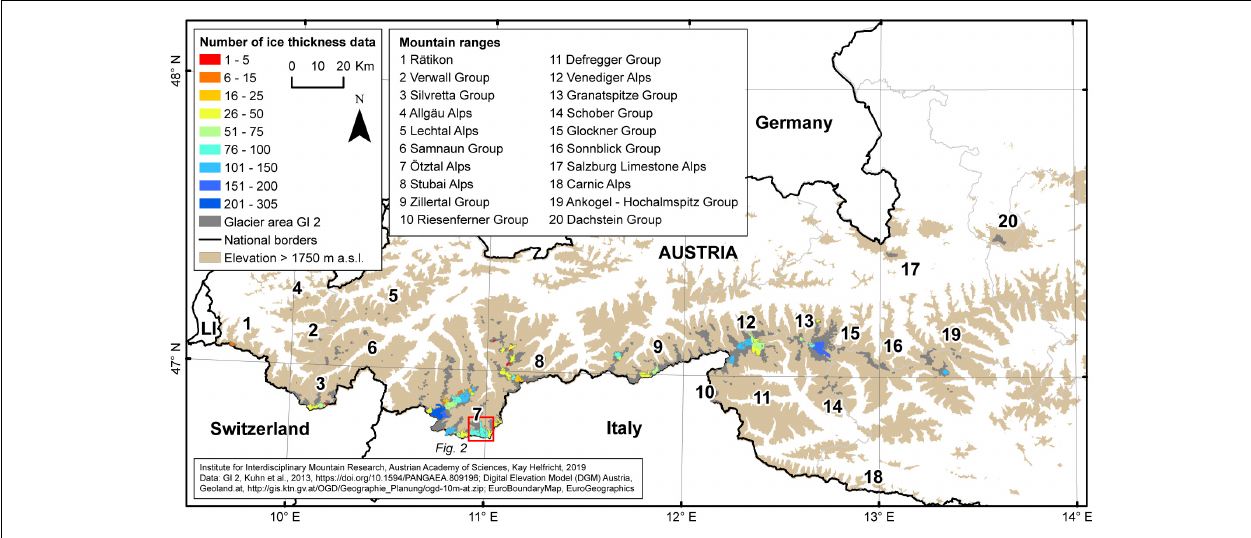
FIGURE 1 | Location of the glaciers according to the second Austrian glacier inventory (gray area, GI 2) overlaid by all glaciers with available ice thickness measurements in color showing the number of ice thickness data points per glacier. The mountain ranges are indicated. The dashed red box highlights the zoom section presented in Figure 2 . The brownish layer shows mountain areas with an elevation above 1750 m